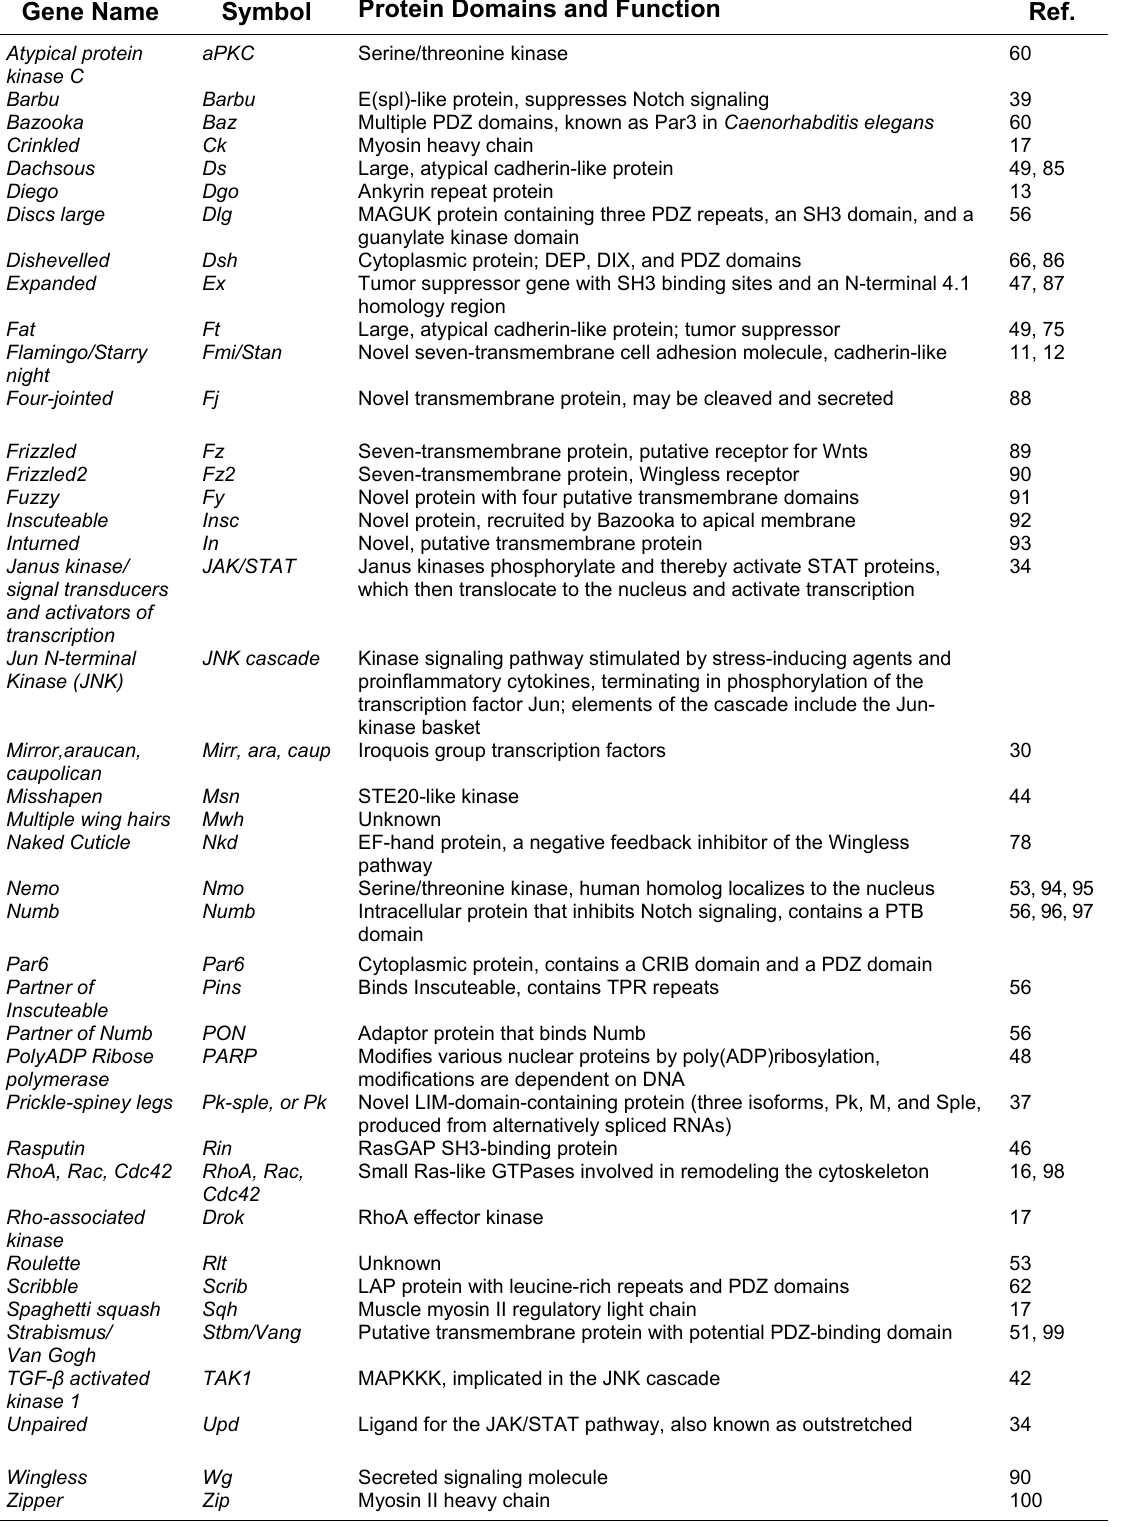
Proteins Known to Participate in PCP Signaling or